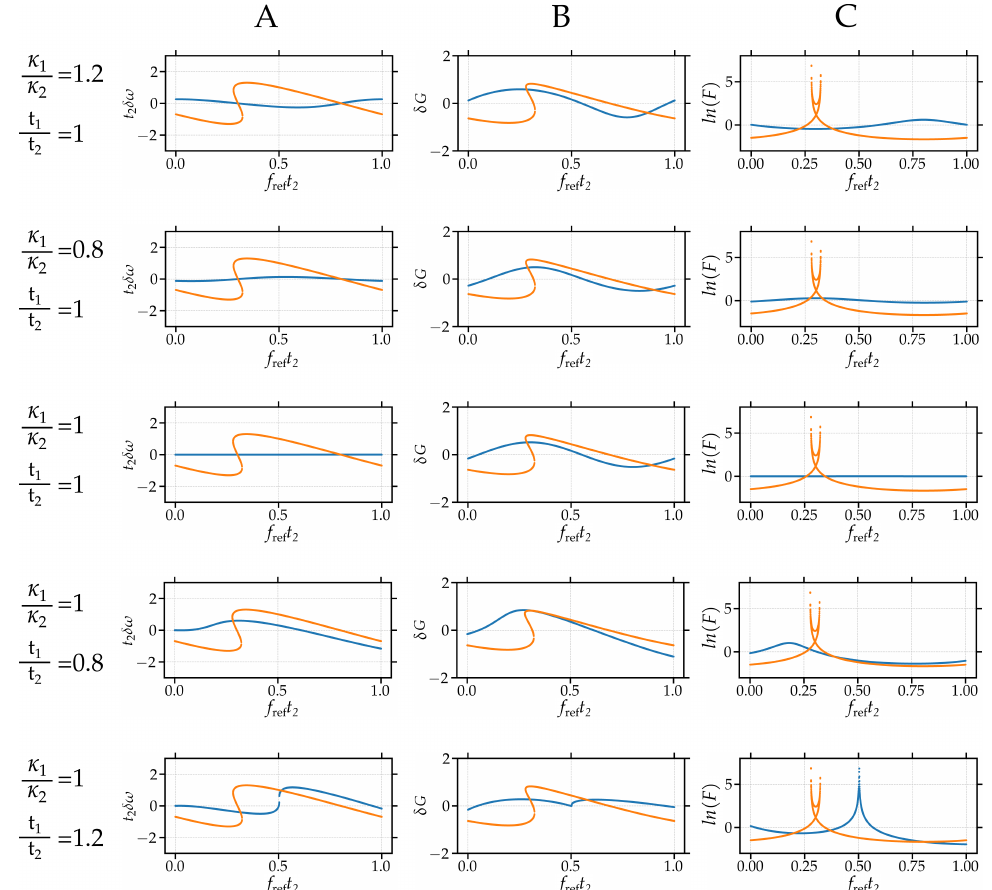
Figure A4. Numerical solutions for C = 1.3 under condition (12) for a ± 20% variation of conditions (8) and (11). Double feedback case shown in blue, single feedback case shown in or- ange. Column ( A ) shows the lasing frequency shift results. Column ( B ) shows the threshold gain shift. Column ( C ) shows the intrinsic linewidth